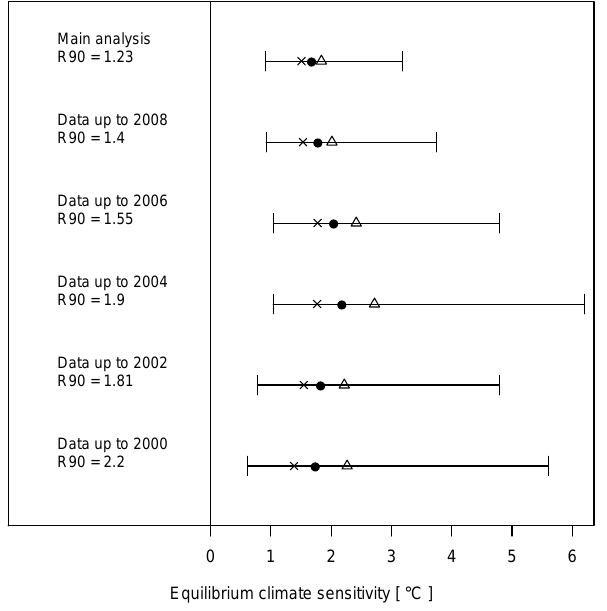
Fig. 5. Posterior means (triangles), medians (dots), modes (crosses), and 90% credible intervals for estimates of ECS using various data sets updated between 2000 and 2010 (2yr intervals). The relative uncertainty measure R90, defined as the width of the 90% C.I. di- vided by the posterior mean, is also